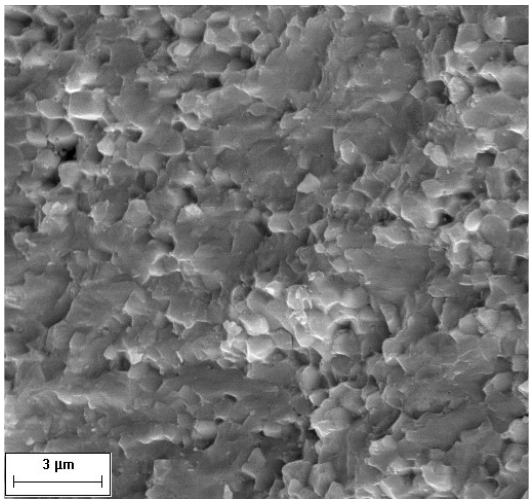
Figure 10. SEM image illustrating the microstructure of a ceramic sample of PZT:3,0%ErB.